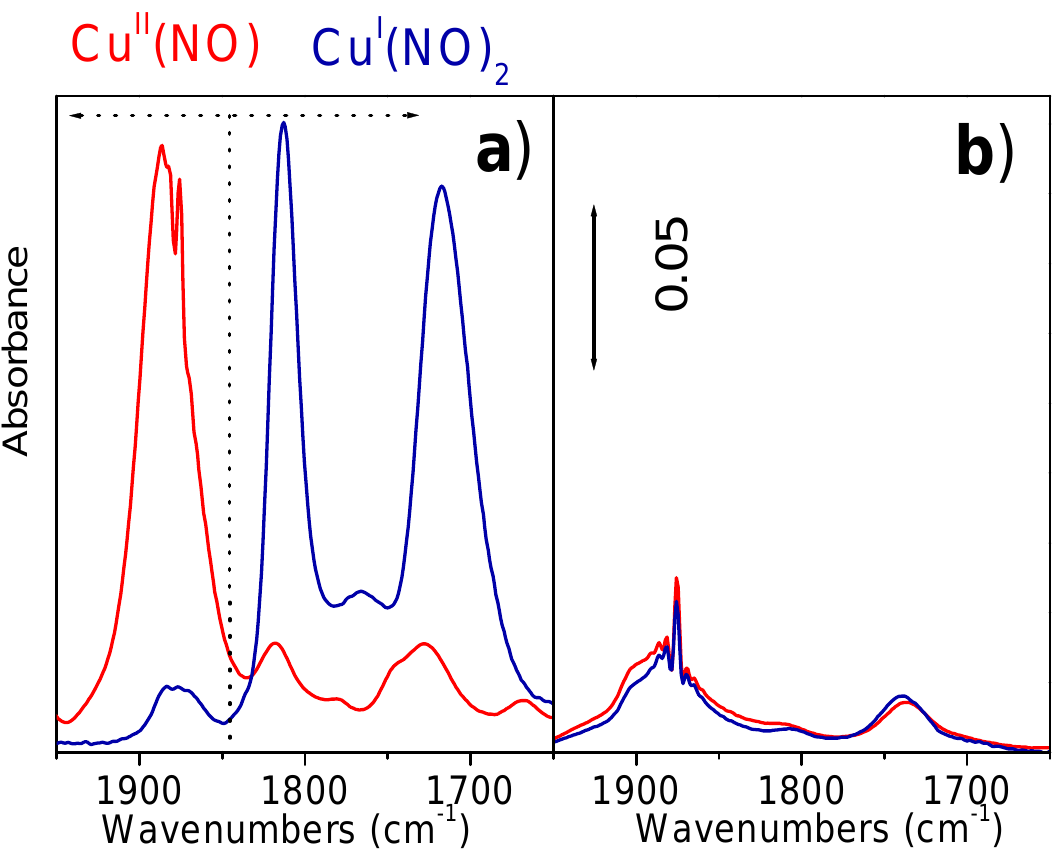
Figure 3: Part (a): IR spectra of NO on Cu5.0 before and after interaction with ethylene at 500 K red and blue curves respectively. Part (b) as part (a) for Cu0.25